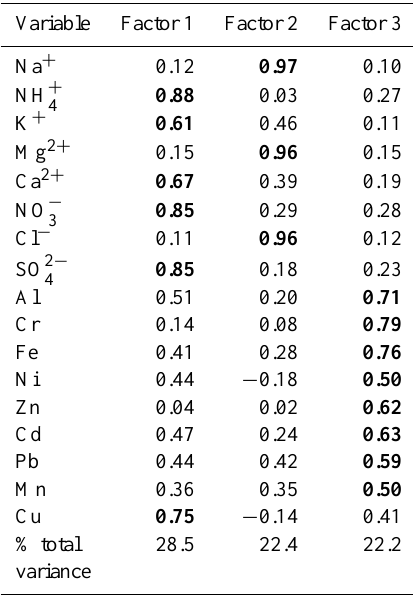
Figure 11. Comparison of mean concentration of major ions and trace metals in initial ( n = 40) and subsequent ( n = 73) rainfall dur- ing 2012.